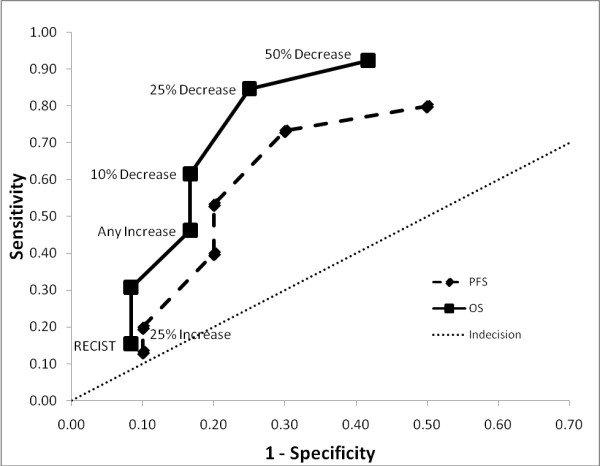
Receiver-Operator Curve of Volume Metrics by Clinical End-point: Receiver-operator curves for volume thresholds in predicting for 2 year overall survival (solid, square) and 1 year clinical progression-free survival (dashed, diamond). Line of indecision is marked as a dotted line.